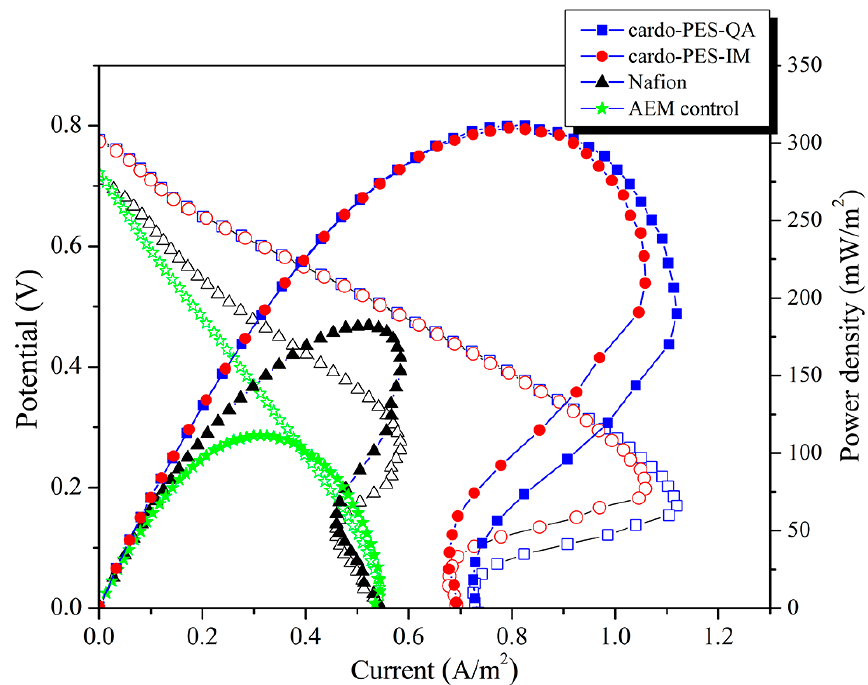
Figure 10. Microbial fuel cell performance of the AEMs and the commercial membranes (solid symbols represent the power density while the corresponding blank symbols represent the potential).